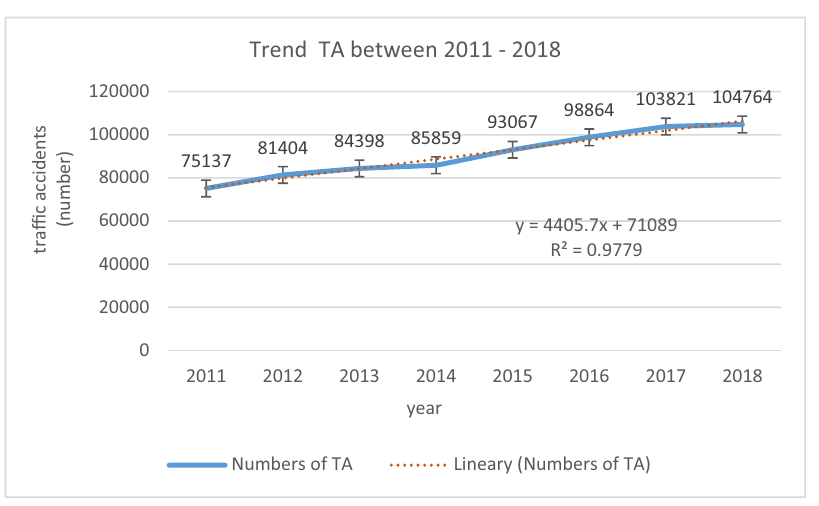
Figure 1: The TA number trend in 2011 –